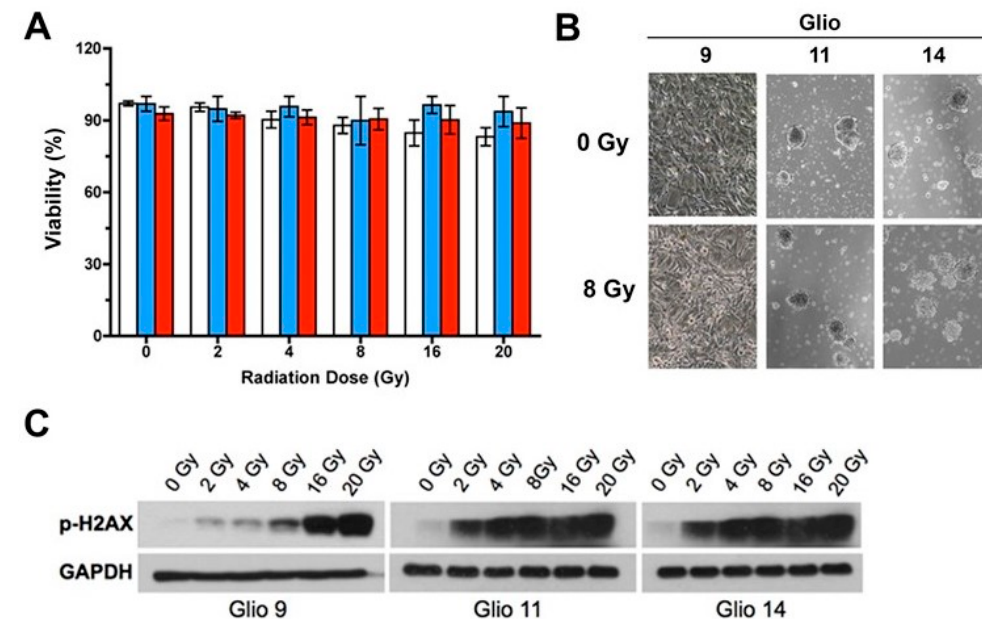
Figure 1. Glioblastoma stem cells (GSCs) exhibit robust radioresistance. ( A ) Viability as determined by trypan blue exclusion assay of Glio9 (white), Glio11 (blue), and Glio14 (red) treated with increasing doses of radiation and then analyzed 72 h after exposure. Results are representative of at least three experiments and displayed as mean ± SEM. ( B ) Light microscopy images of GSC neurosphere phenotype with and without radiation treatment. Magnification: 10×. ( C ) Western blot of p-H2AX, a marker for double strand breaks, in GSCs exposed to increasing radiation.